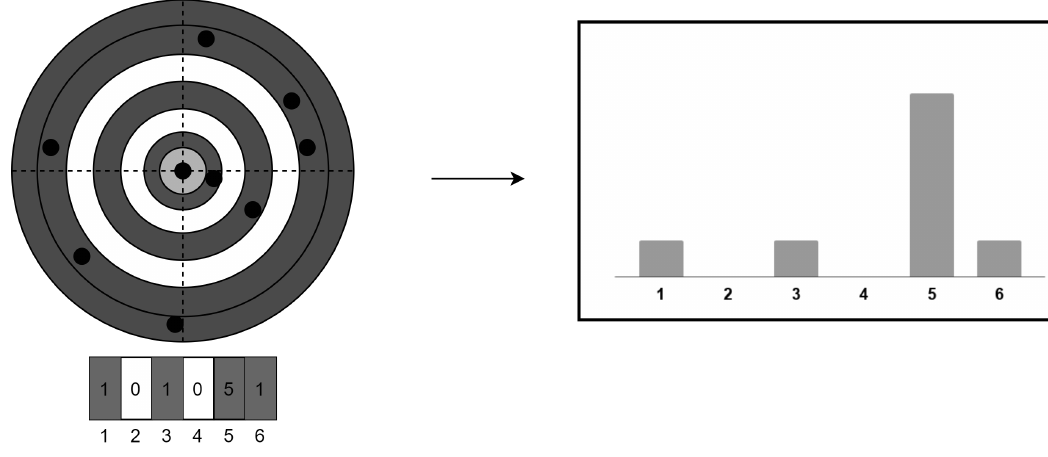
Figure 1. Feature extraction